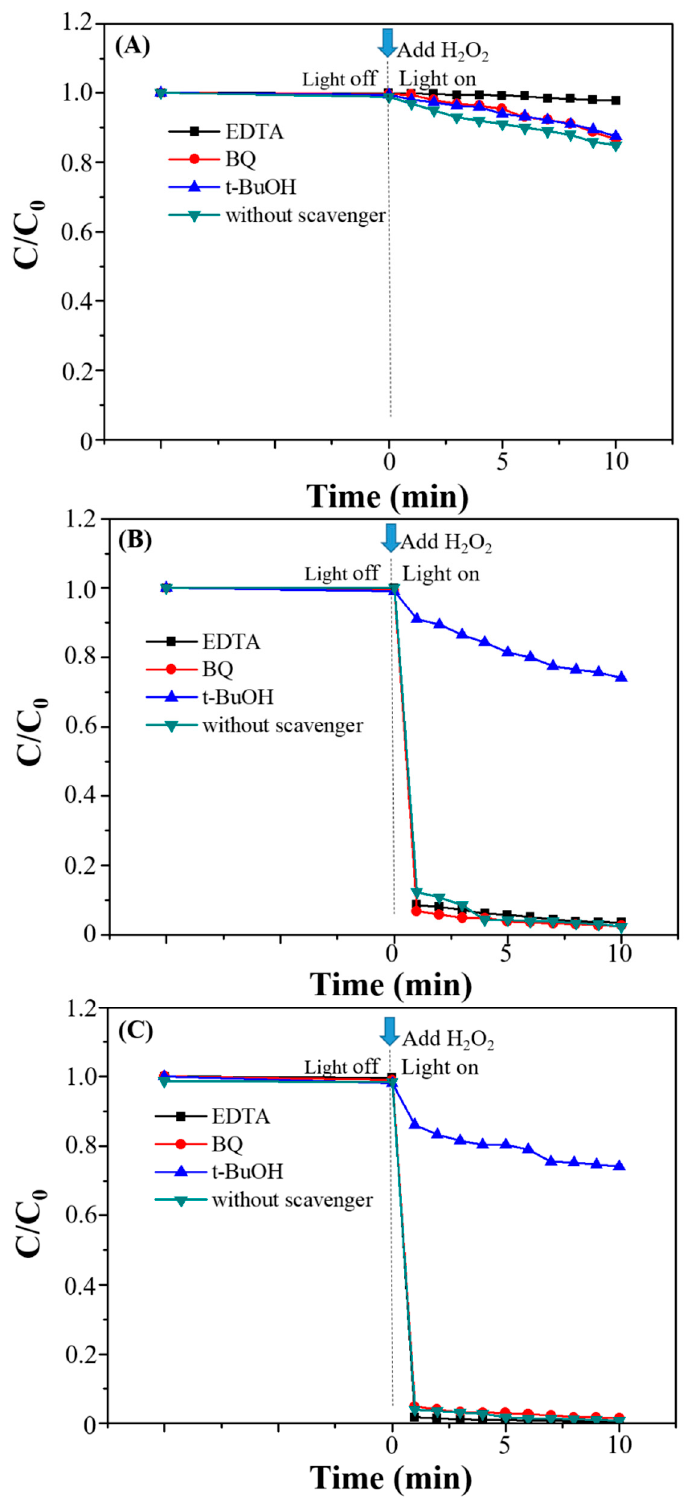
Figure 14. Free radical trapping experiment of ( A ) Ag 3 PO 4 , ( B ) CuFeS 2 , and ( C ) CuFeS 2 / Ag 3 PO 4 composites. Ethylenediaminetetraacetate (EDTA), tert-butanol (t-BuOH), and p-benzoquinone (BQ) (each 1 mM) were scavengers for holes, oxygen radicals, and hydroxyl radicals, respectively. Hydroxyl radical production was further detected using the fluorescent luminescence (FL)